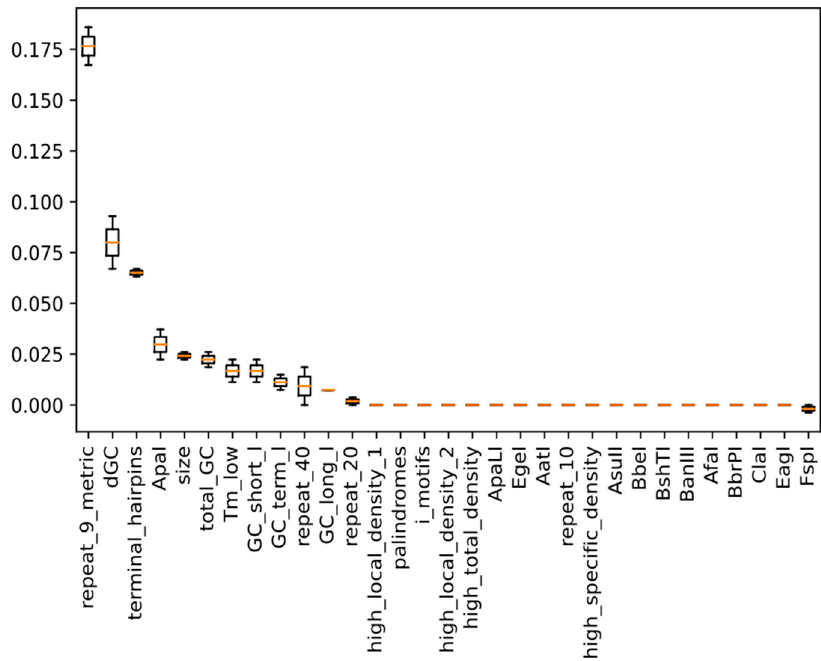
Figure 3. The relative importance of all 31 features.